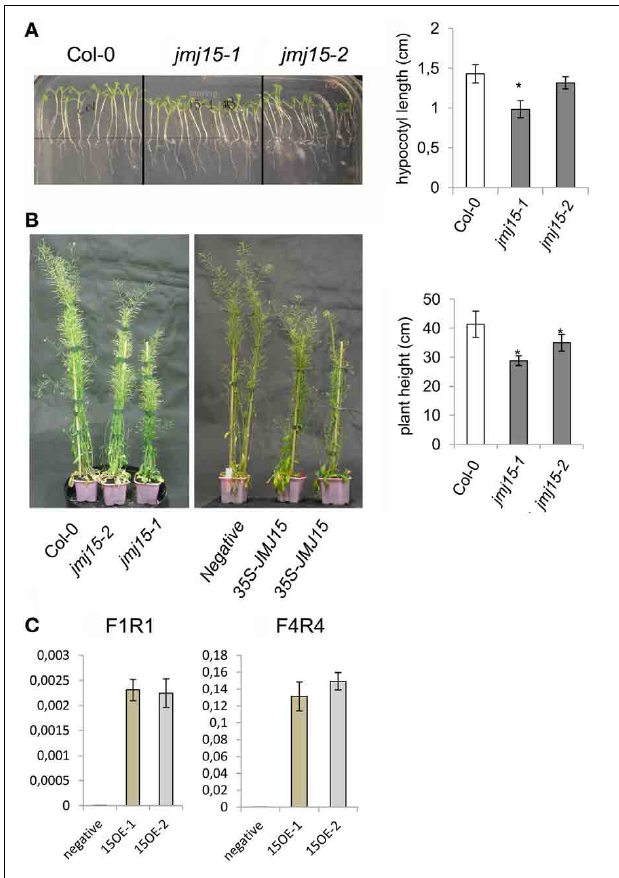
FIGURE 3 | Jmj15 gain-of-function mutations reduced plant height. (A) Phenotype of hypocotyls of short day-grown (in ½MS medium) seedlings of jmj15-1 and jmj15-2 compared to wild type col-0 (left). Lengths of hypocotyls were measured from 30 plants per genotype (right). (B) Plant height at mature stage of jmj15-1 and jmj15-2 compared to wild type (left) and of 35S-JMJ15-HA over-expression plants compared to negative transgenic plants (middle) grown in soil in greenhouse under long day conditions. Plant heights were measured from 10 plants per genotype (right). Bar = means ± SD. Asterisks indicate the significance of difference from wild type by student t -tests ( P < 0 . 01). (C) JMJ15 transcript levels (relative to ACTIN2 transcripts) in over-expression transgenic positive (15OE-1 and 15OE-2) and negative plants.